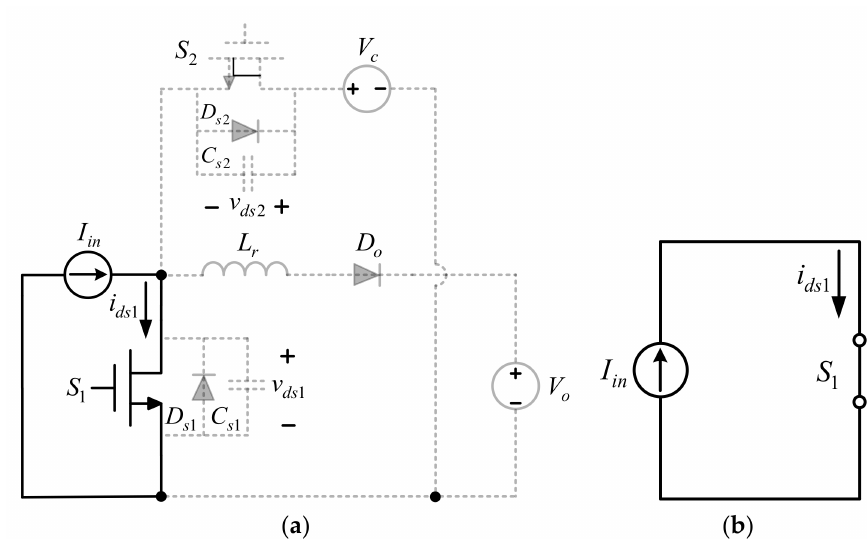
Figure 4. ( a ) Current path for stage 1; ( b ) equivalent of ( a ).